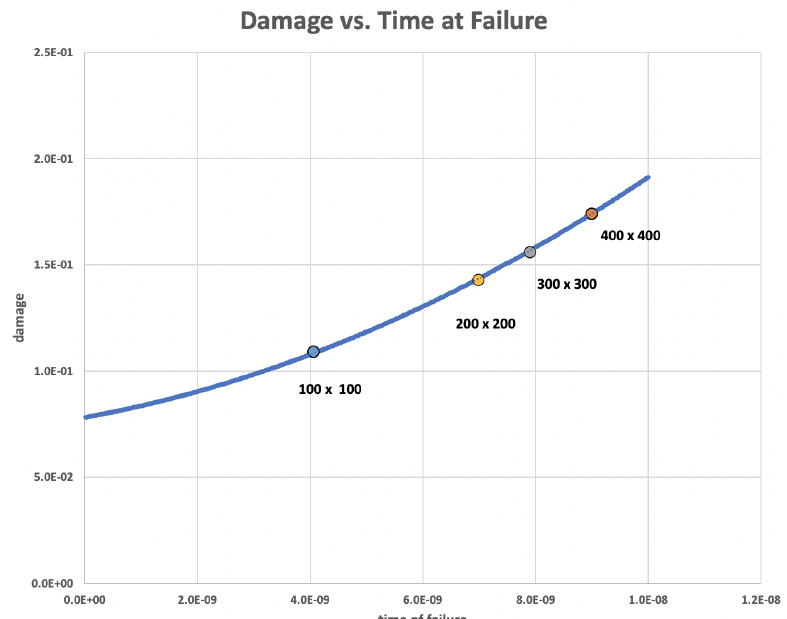
Figure 9. The ensemble-averaged damage is plotted as a function of time for an imposed strain rate ˙ ϵ = 1 × 10 5 s − 1 , an ensemble size of 100 and the process zone is 10% of crack radius. The four dots represent damage at time of failure for DX = 100,200,300,400 µ m and DY = DX . The damage backbone is the same for all cell widths, but the time to failure increases with the cell